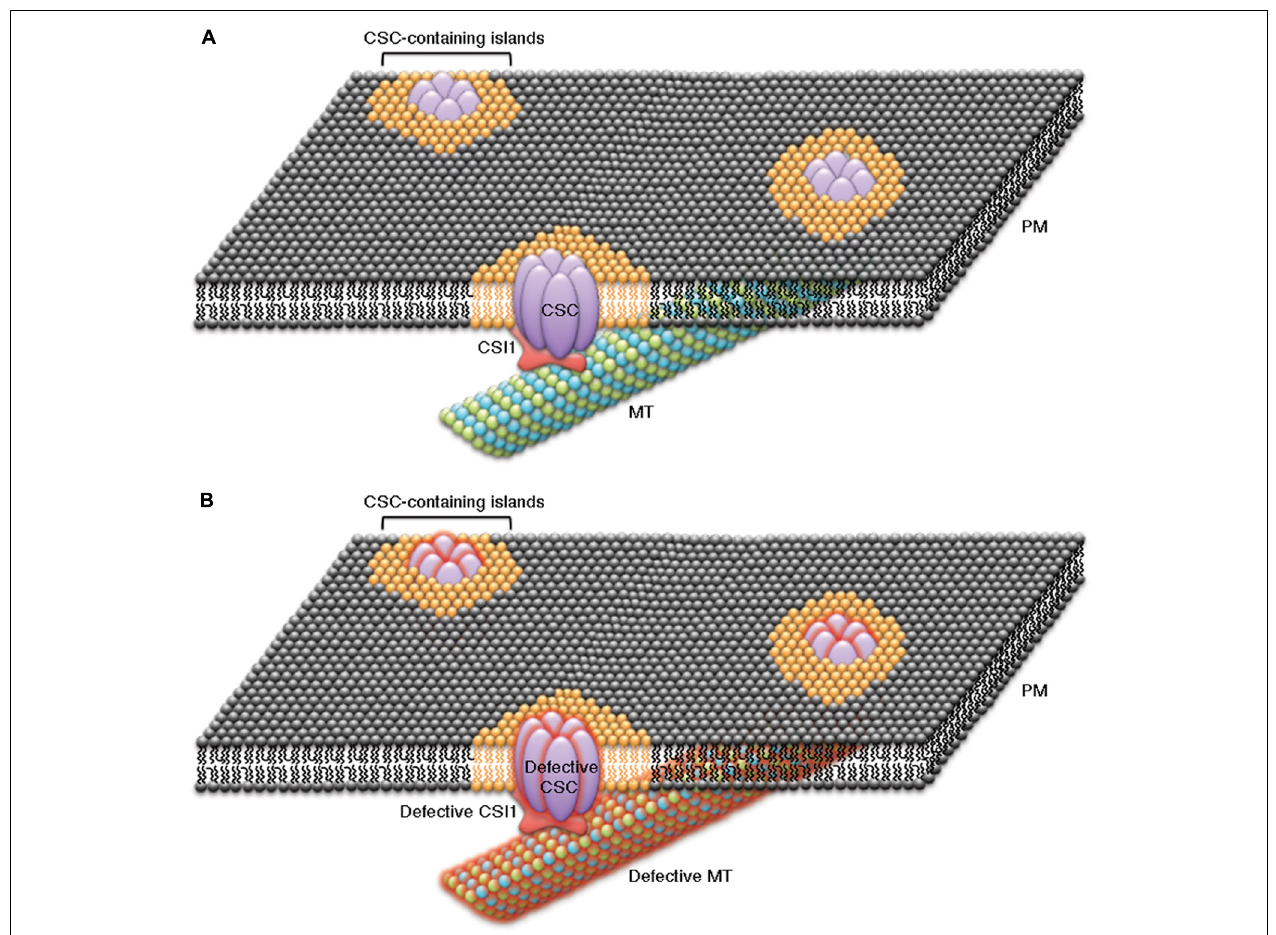
proteins, specialized lipids, and cortical microtubules, are closely associated. Under normal conditions CSCs that are within CSC-containing islands move along cortical microtubules during cellulose biosynthesis in a CSI1-dependent manner. (B) A defect in any single component of the CSC continuum causes a disruption of each of the other components of the continuum. Examples of experimental evidence that supports the CSC continuum model include: disruption of cortical microtubules influences the distribution and dynamics of CSCs and CSI1, genetic disruption of CSI1causes changes in both CSCs and cortical microtubules, and genetic disruption of CSCs or CSC-associated proteins (e.g., KOR1) affect the organization of cortical